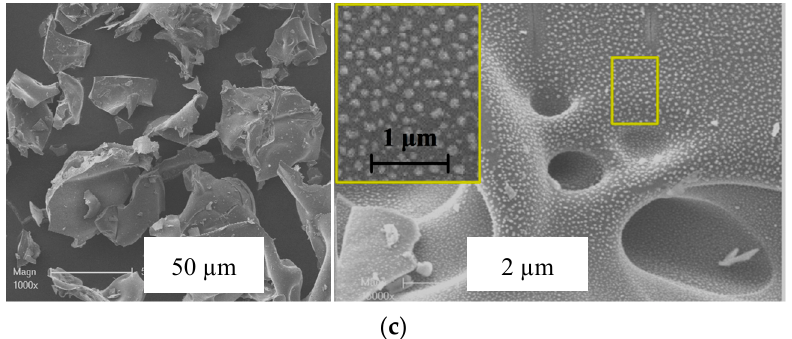
Figure 3. SEM images of the ( a ) 5Ni5CoAl, ( b ) 5Ni5CuAl and ( c ) 5Co5CuAl catalyst samples.